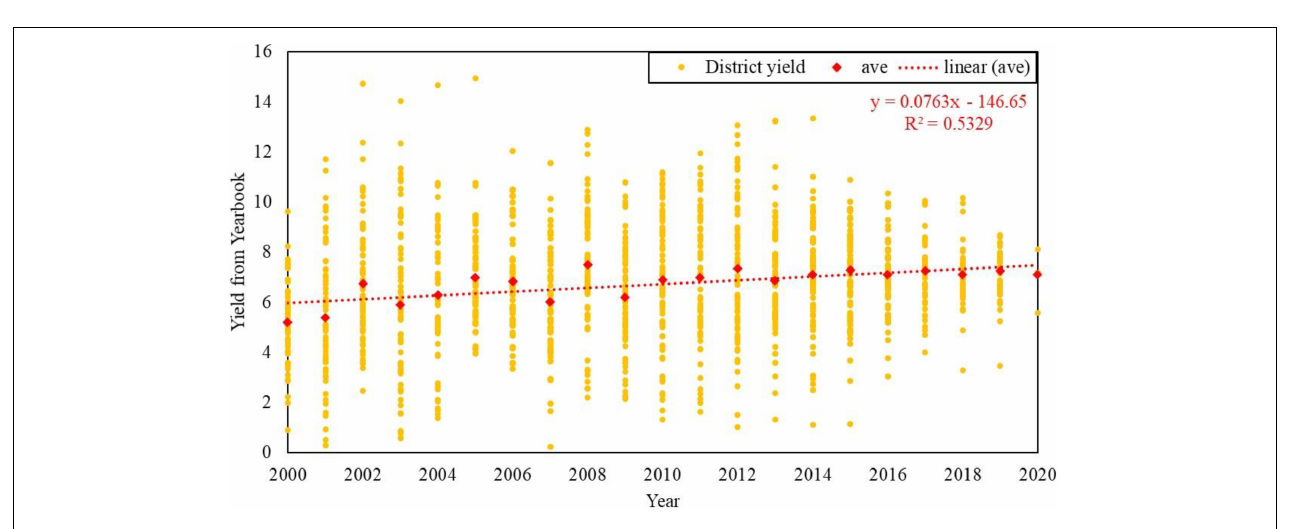
FIGURE 4 | Maize yield (t/ha) dataset from 2000 to 2020’s Statistical Yearbook.